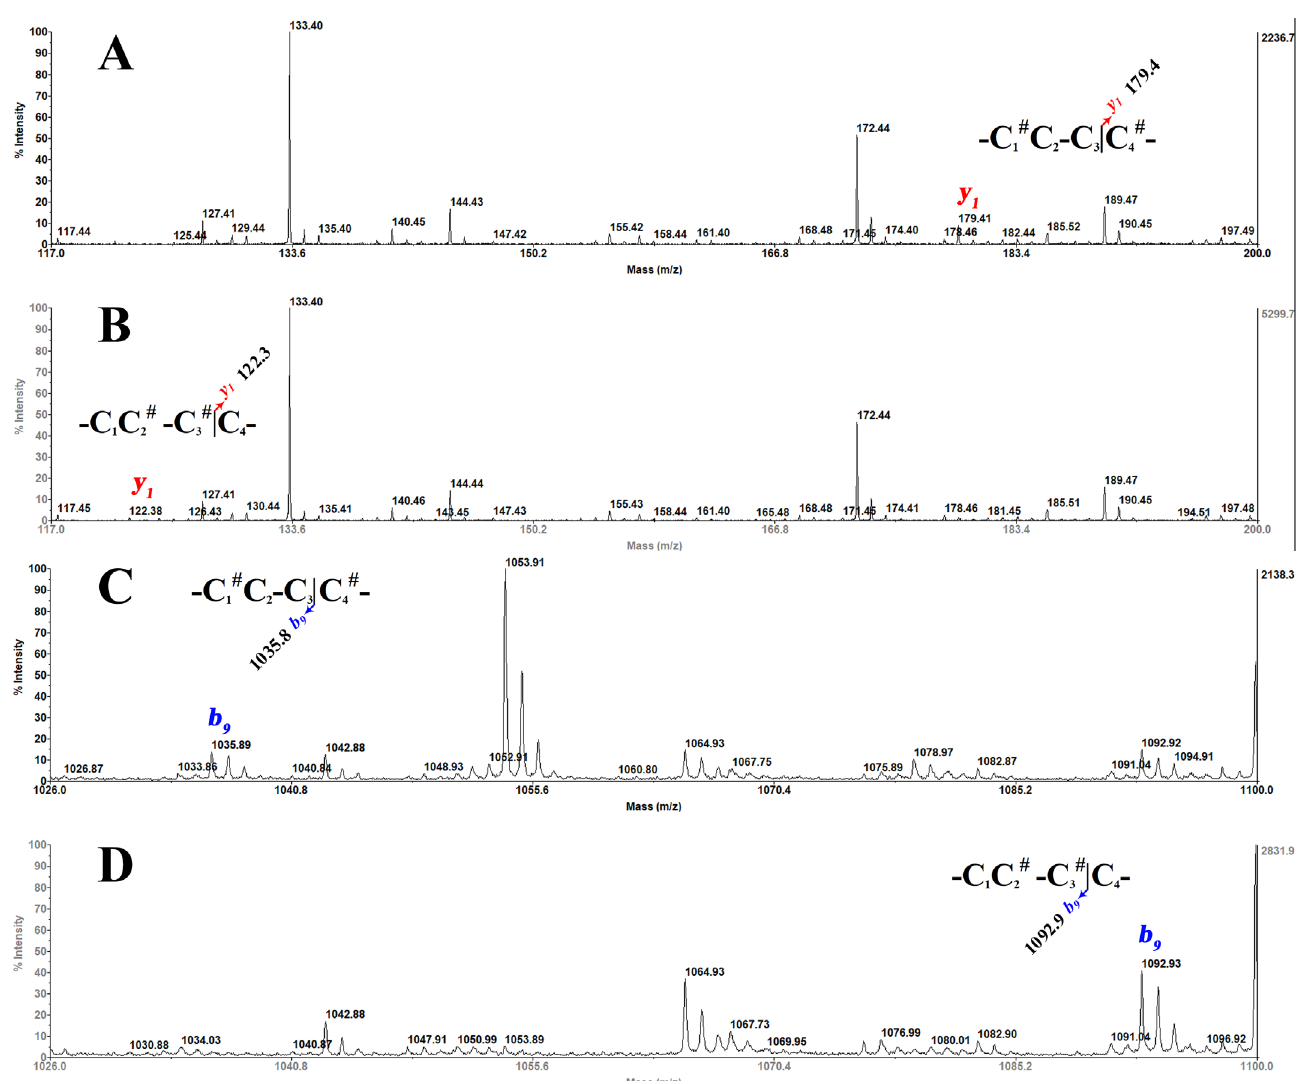
Figure 6. Close-up of the key fragment ions between two modified species in the determination of Bn5a cysteine-connectivity: A portion of the CID mass spectrum of C